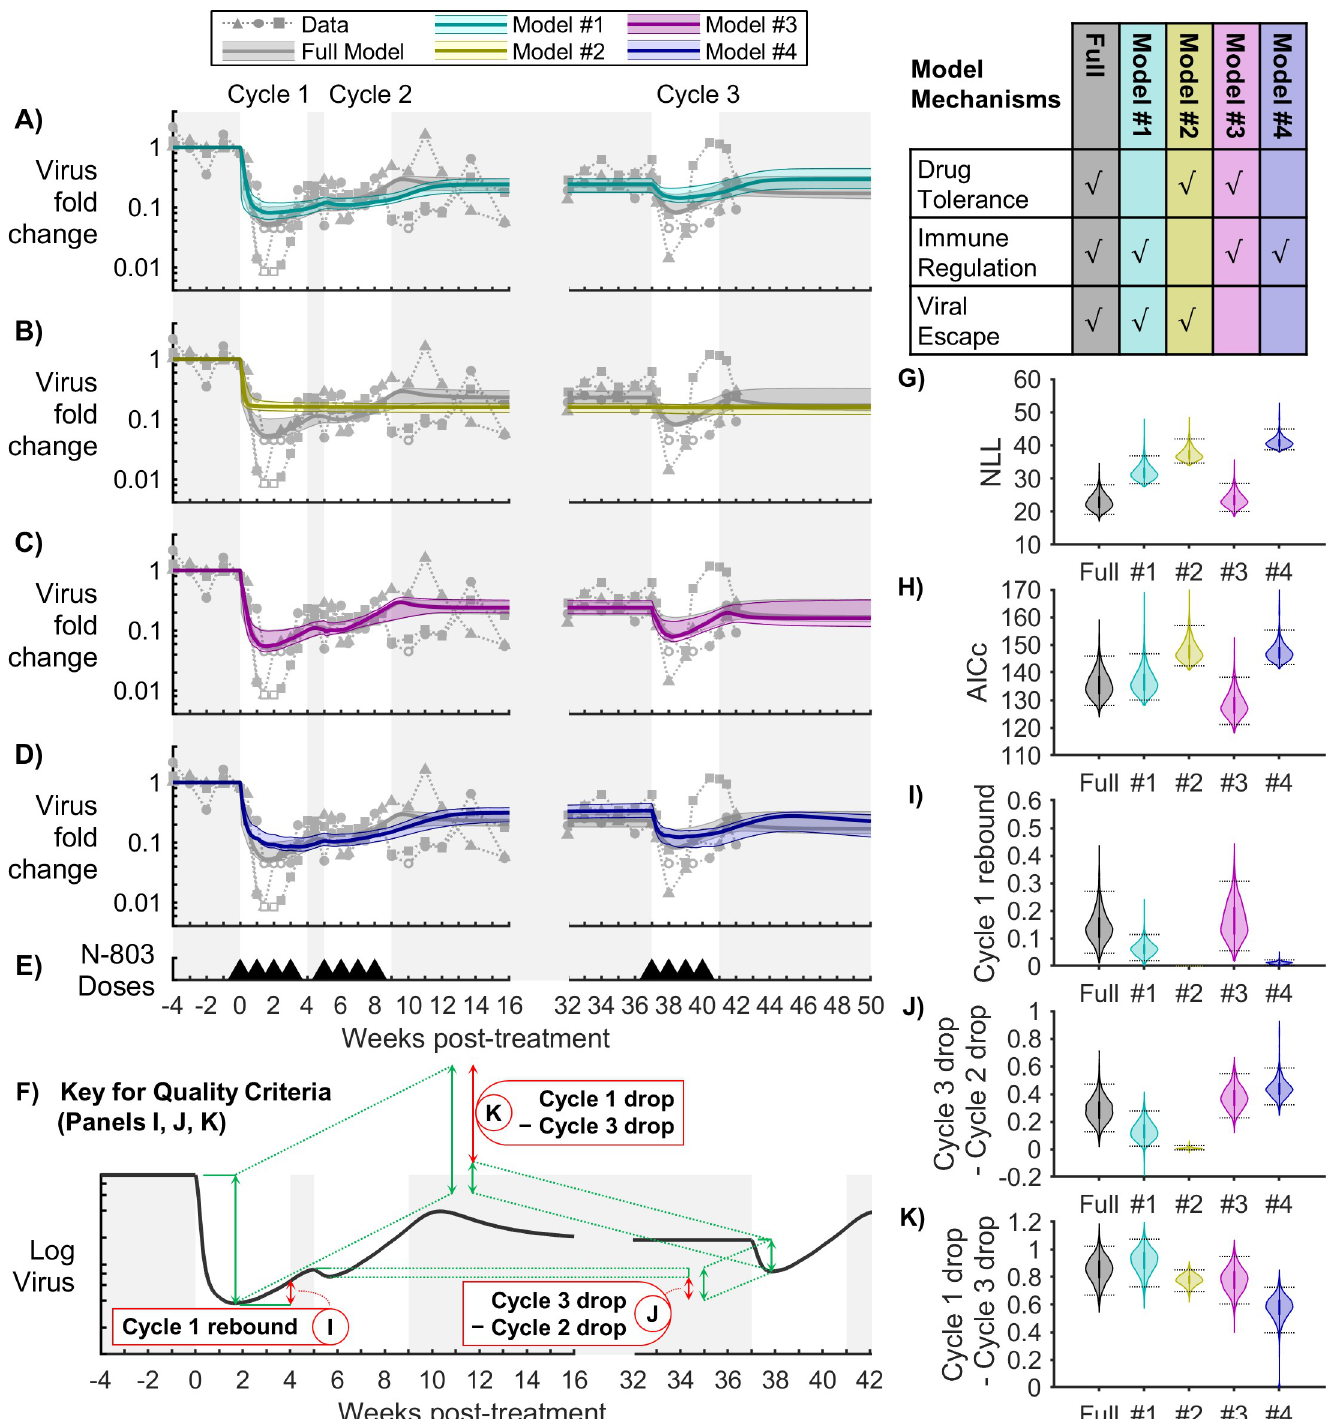
Fig 4. Model comparison for viral load. Models with different combinations of mechanisms were compared to assess the importance of drug tolerance, immune regulation, and viral escape. Panels (A-D) compare the fold change in virus between the full model and models #1-4, respectively. The bold line corresponds to the best-fit model, and the shaded region corresponds to the Bayesian 95% credible interval. Data from N-803-treated SIV-infected NHPs are shown as different symbols for each NHP [16]. Open symbols were at the lower limit of detection for the viral assay (100 CEQ/mL) and were omitted from parameter estimation. Panel (E) shows timing of 0.1 mg/kg subcutaneous doses of N-803. Panels (G,H) show the corresponding Negative Log-Likelihood (NLL, Eq 20) and Akaike Information Criterion (AICc, Eq 21) for the Bayesian MCMC samples. Panels (I-K) show the three quality criteria, which are described in panel (F). Bayesian 95% credible intervals are marked. Multiple comparison tests on the quality criteria (I-K) showed a statistically significant difference between all models (p < 0.01). https://doi.org/10.1371/journal.pcbi.1009204.g004 PLOS Computational Biology | https://doi.org/10.1371/journal.pcbi.1009204 July 28,